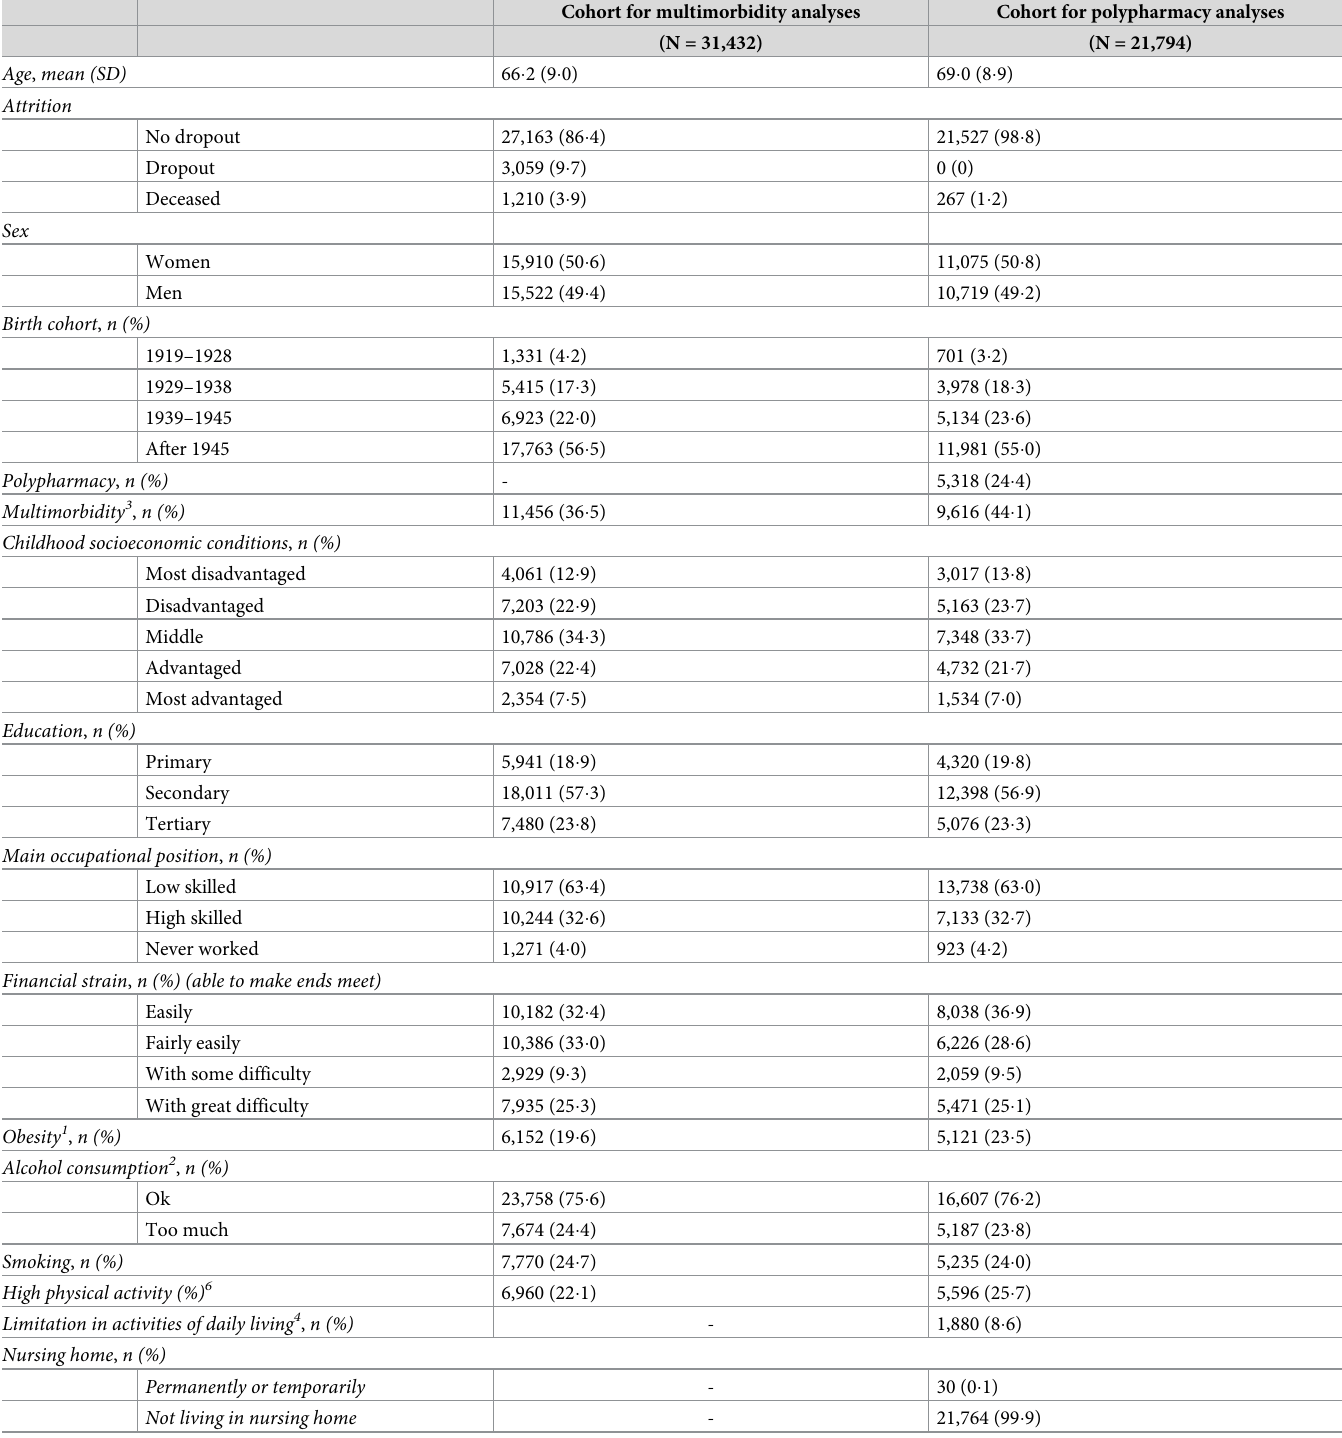
Table 1. Baseline characteristics of study participants.